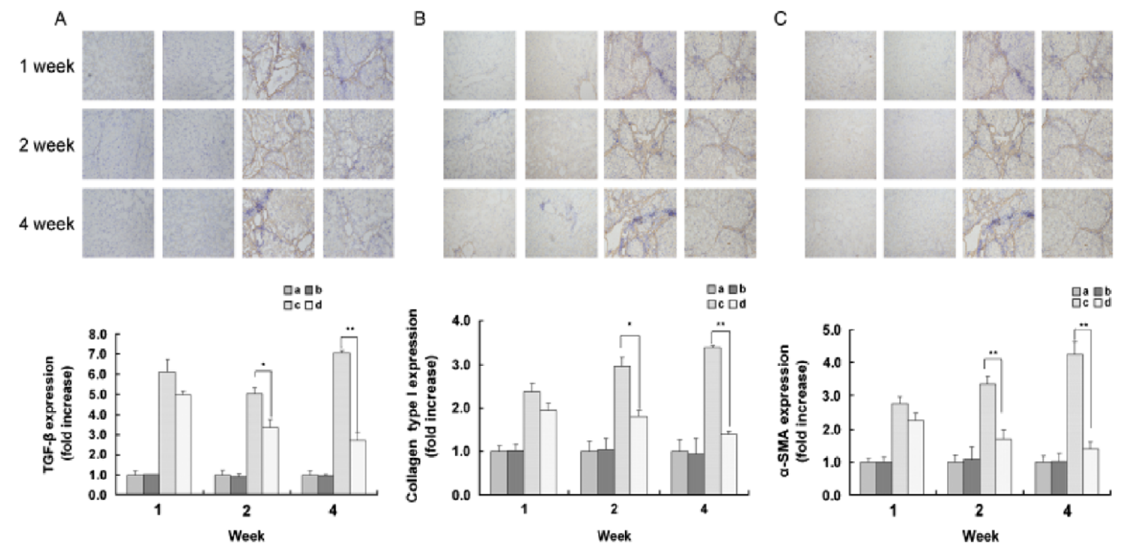
Figure 2. Expression of select fibrotic factors via immunohistochemistry. ( A – C ). TGF-β1 ( A ), collagen type 1 ( B ) and α-smooth muscle actin ( C ) expression at 1, 2, and 4 weeks. It can be visually determined that the fibrotic effect is reduced with treatment of human umbilical cord blood-derived mesenchymal stem cells (hMSCs) as opposed to CCl4 induced cirrhosis and saline. Mice livers injected with saline (left), olive oil and hMSC injection (left center), CCl4 induced cirrhosis with saline injection (right center) and CCl4 induced cirrhosis with hMSC injection (right) on each of the three panels. The MSC injection group shows a 4-fold decrease in αSMA and TGF-β and a 3-fold decrease in collagen 1 at 4 weeks with n = 5 mice. The study demonstrates MSC homing into the cirrhotic livers more so compared to healthy livers, further signifying the efficacy of the cellular therapy. Original magnification of 200×. Values are presented as mean ± SEM, for at least five separate experiments. Data are presented as fold change with respect to saline/CCl4 group, * p < 0.05, ** p < 0.01. Reprinted with permissions from Jung et al. [79].